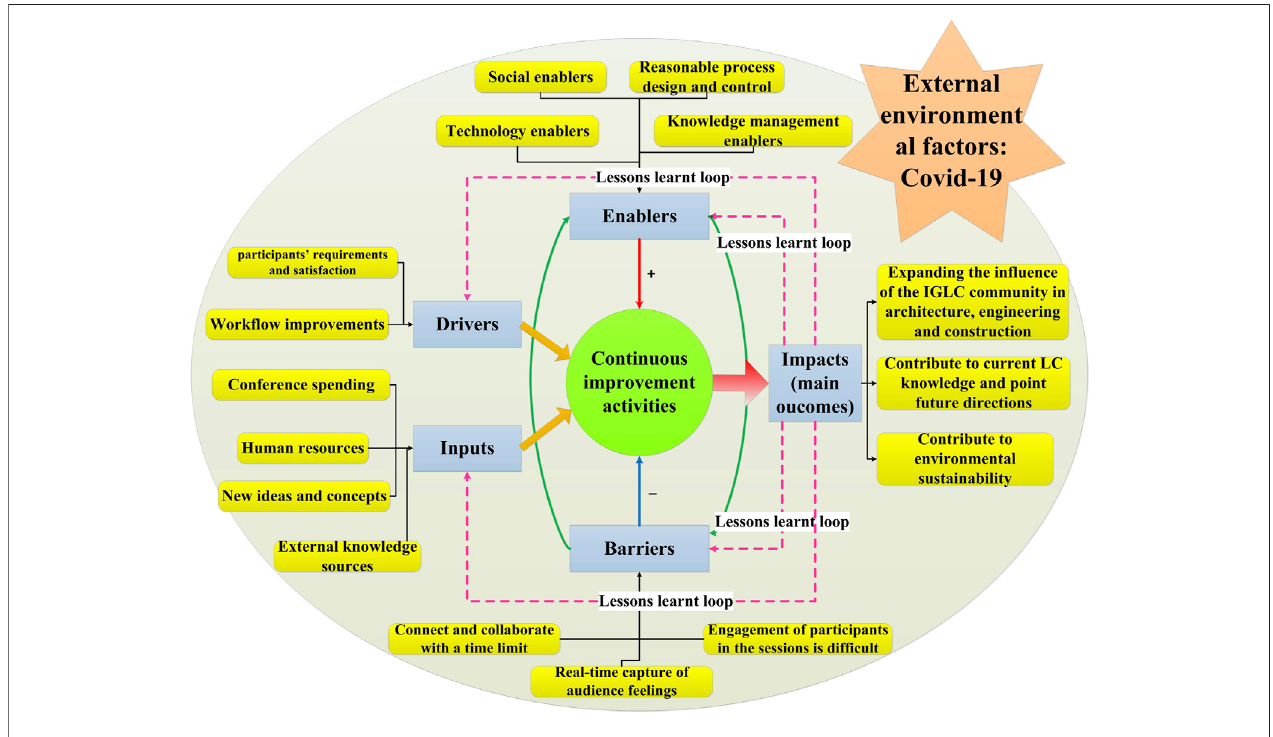
FIGURE 3 | A model for a virtual international academic conference.